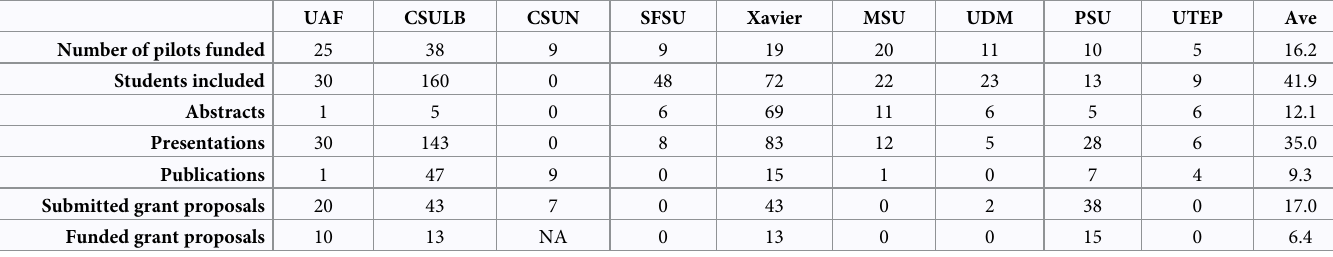
Table 4. Count of productivity measures at each BUILD primary institution,